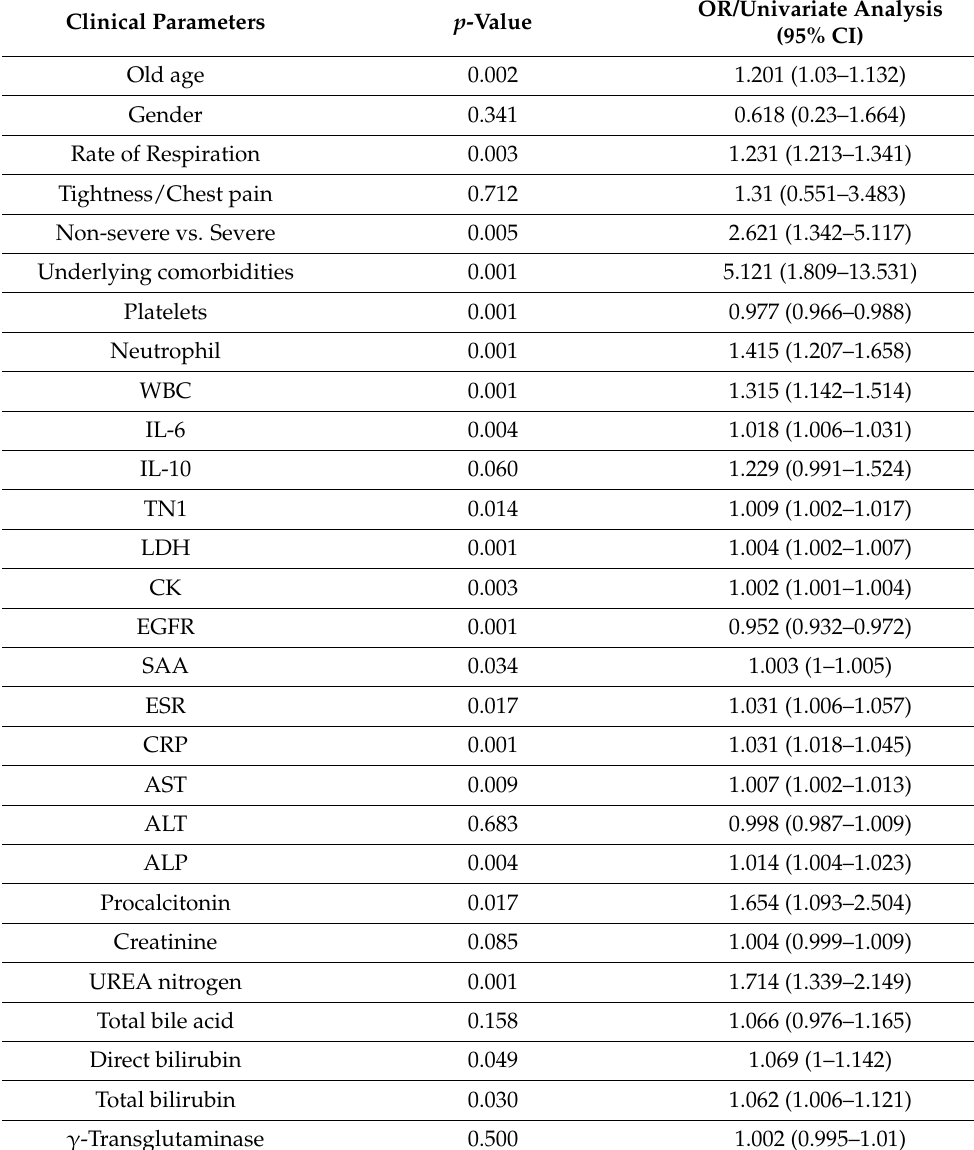
Table 3. Risk Factors for COVID-19 Associated